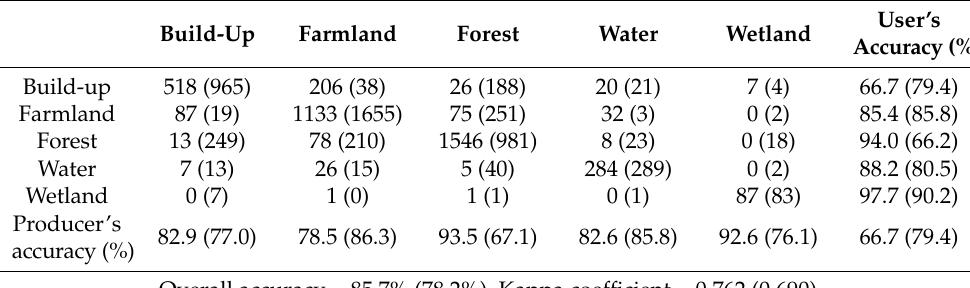
Table 3. Accuracy assessments for the land use classifications of the HGBA in 2007 and 2020 (the values in the brackets come from 2007, otherwise the values come from